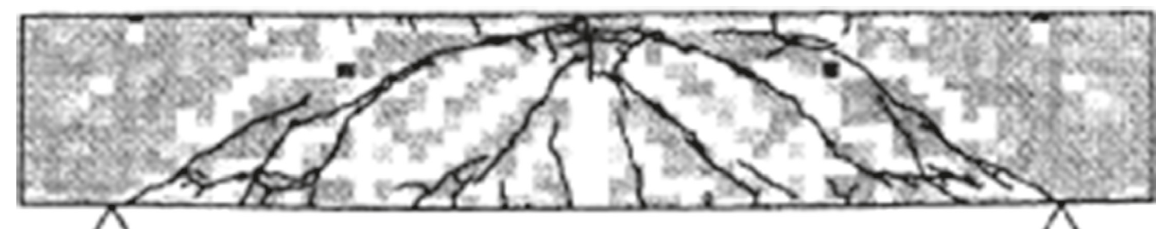
Figure 9: Crack pattern of RC beam experiment [15]. Table 8: Sensitivity parameters of three kinds of concrete strength. Concrete strength